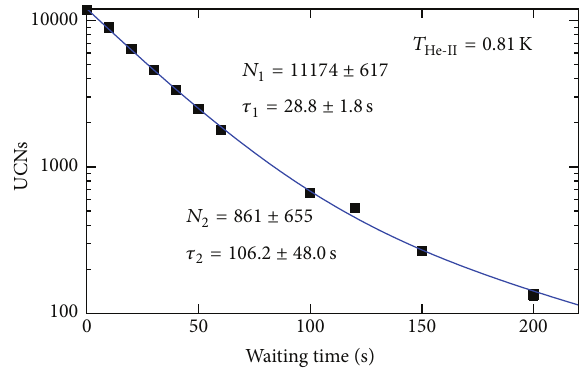
Figure 12: Storage time of UCNs in the source with Ti windows.